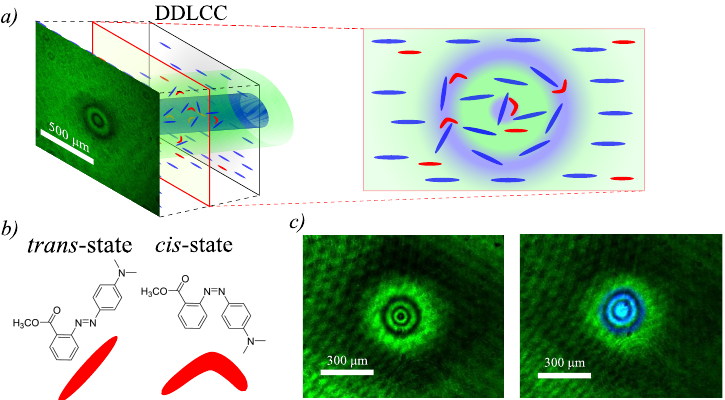
Figure 1. Ring patterns induced by light in a dye-doped liquid crystal cell (DDLCC). ( a ) Schematic representation of the experimental system. The blue and red bars, respectively, account for the molecules of the liquid crystal and azo-dye. The cell is illuminated by a blue and green beam. The snapshot accounts for the observed ring patterns. A transversal plane in the DDLCC is schematically represented. The areas under higher blue laser irradiation are more disordered, while the zones less illuminated preserve the nematic order. ( b ) Isomers of the molecule methyl red methyl ester. ( c ) Two snapshots showing the observed pattern (upper panel) and snapshot with the beam that induces photo-isomerization superimposed (bottom